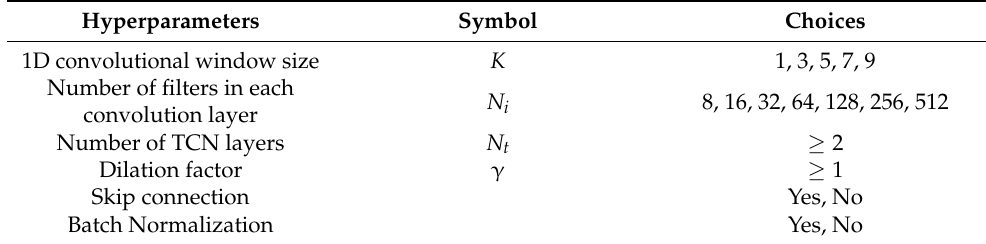
Table 1. Search space of the TCN using Bayesian